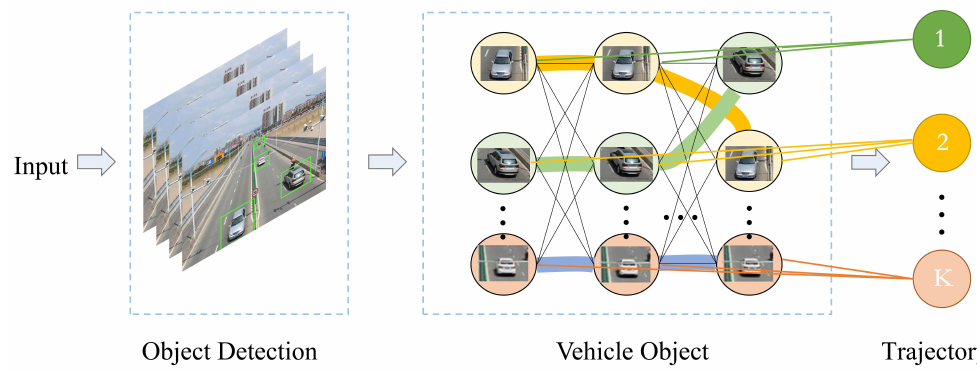
Figure 10. Schematic diagram of algorithm from trajectory to